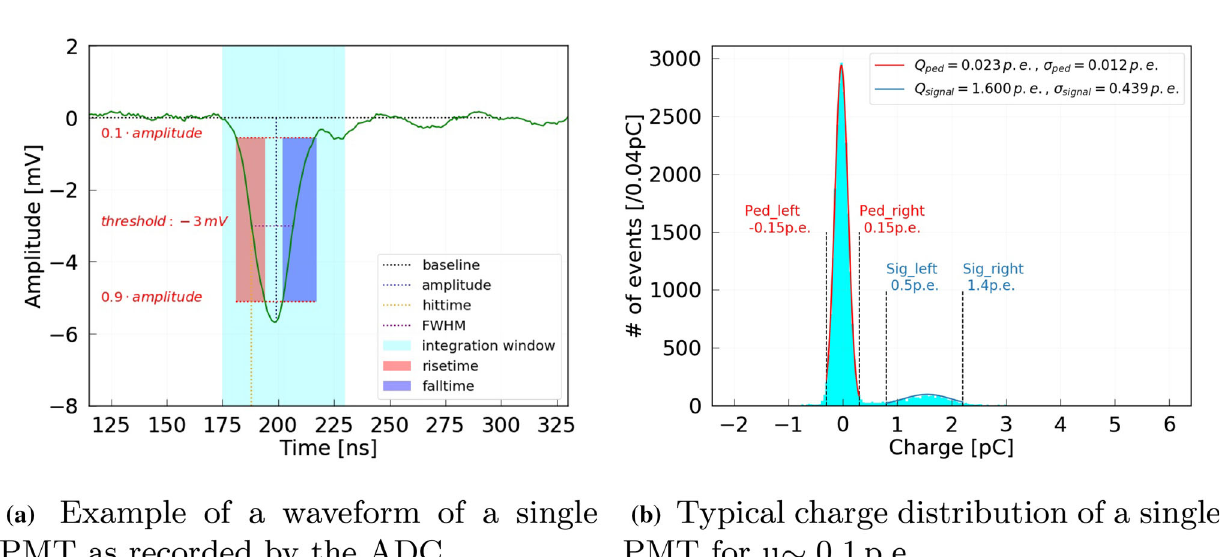
Fig. 10 Typical plots of an averaged waveform from a single PMT (left, also showing the typical definitions used for the following analysis) and the corresponding integrated charge spectrum from these waveforms (right). The SPE peak is located around 1.602pC in the case of a gain of 1 × 10 7